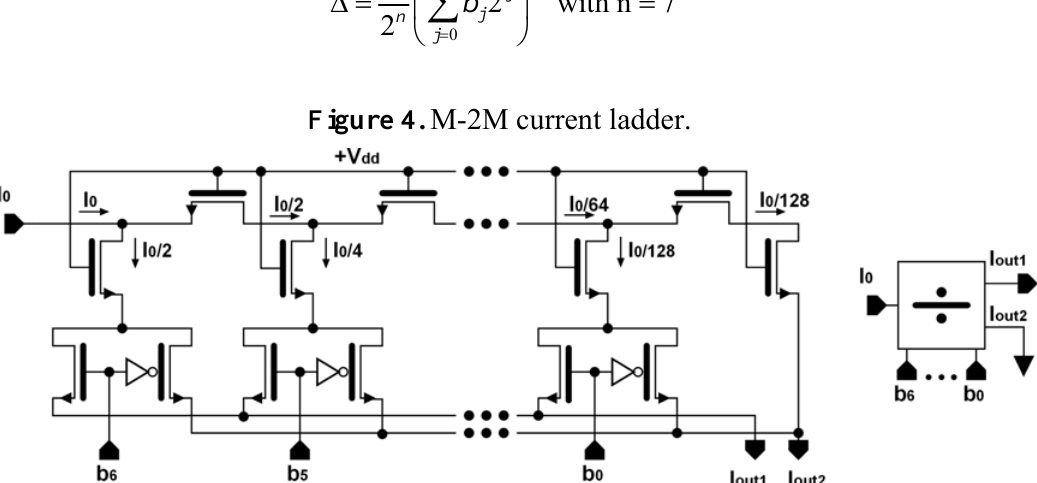
Figure 4. M-2M current